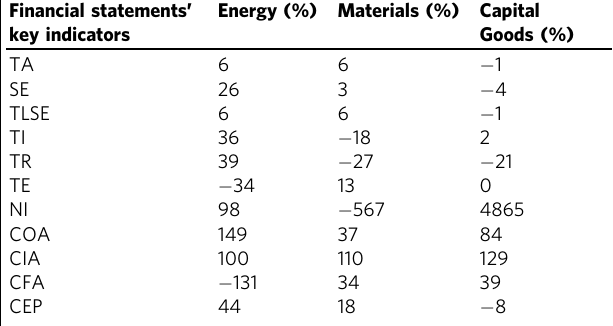
Table 3 increase or decrease in values of fi nancial statements ’ key indicators in terms of the average between Energy, Materials, and Capital Goods